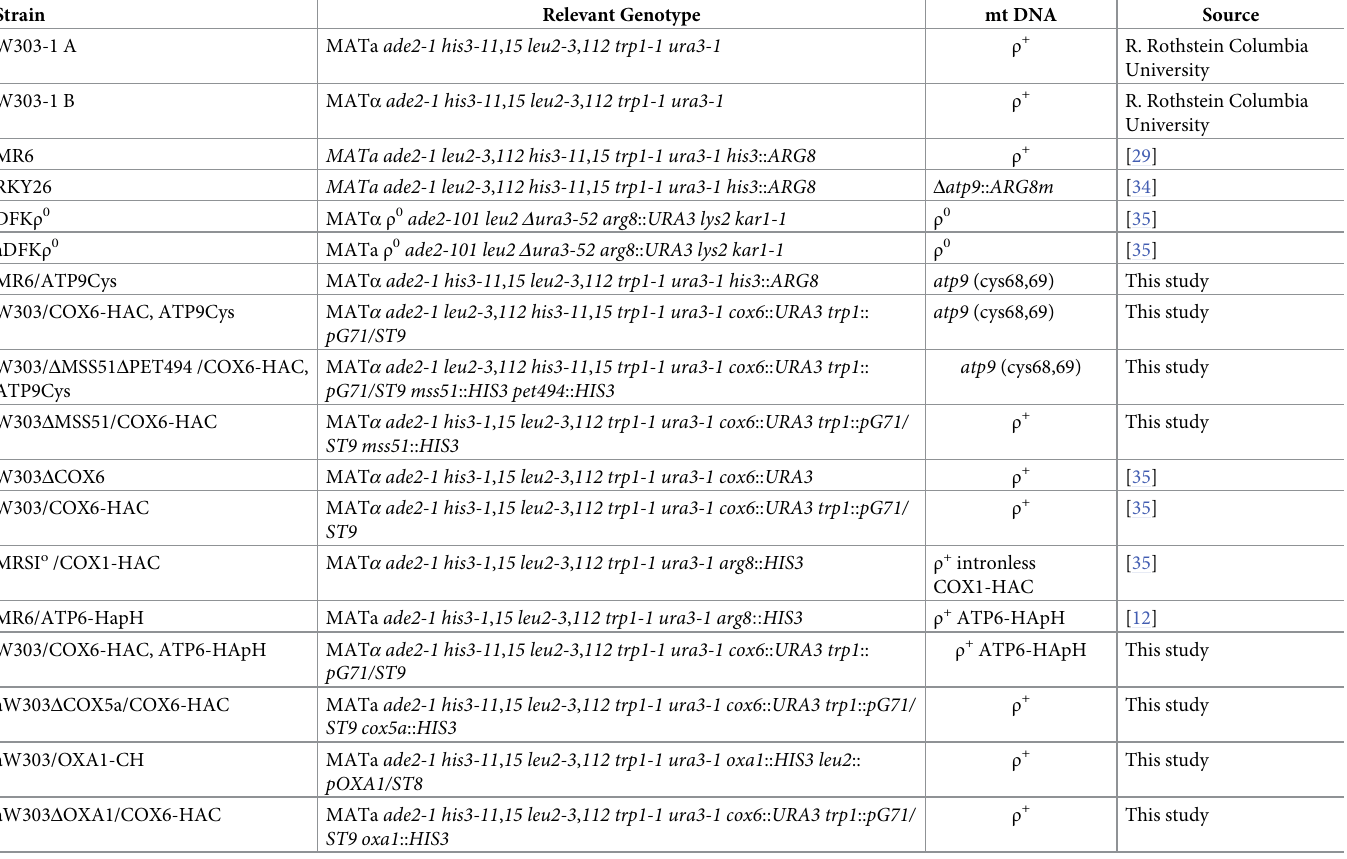
Table 2. Genotypes and sources of the S . cerevisiae strains used in this